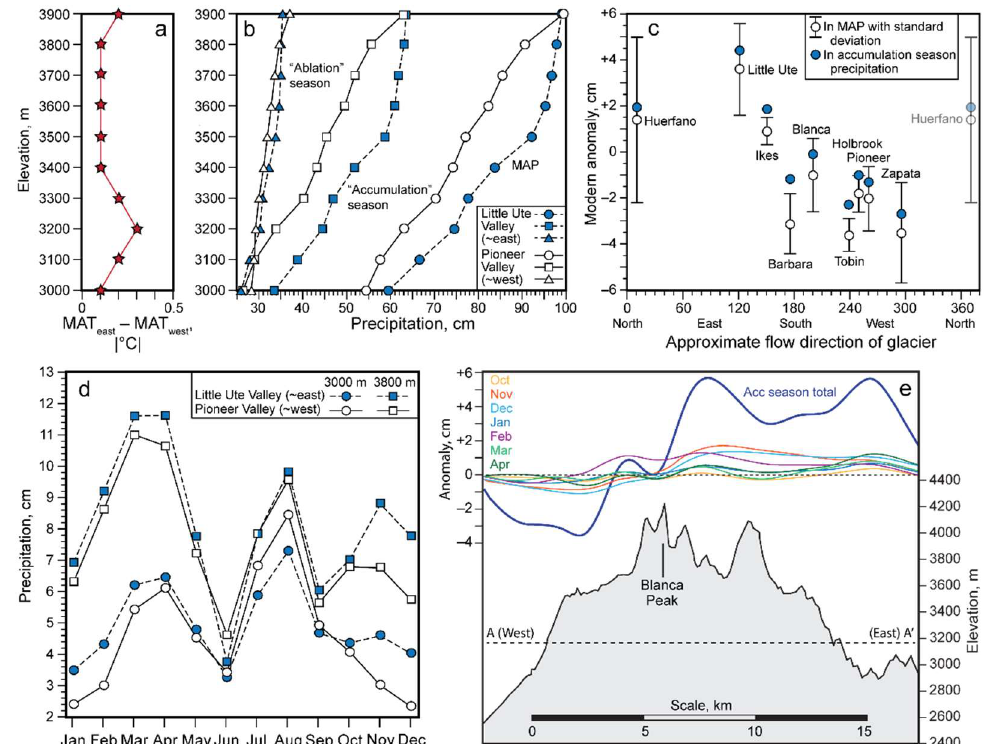
Figure 3. Similarities and differences in ( a ) mean annual temperatures MAT, ( b ) mean annual, accumulation season, and ablation season precipitation on the eastern and western side of the Blanca Massif exemplified by the Little Ute and Pioneer valleys. ( c ) Mean precipitation anomalies over individual glacier areas plotted against the direction of glacier flow in the main valley. ( d ) Monthly distribution of precipitation at two elevations in the Little Ute and Pioneer valleys. ( e ) Monthly contributions to accumulation season precipitation anomaly along an east–west transect (shown in Figure 2d) through the summit of Blanca Peak.